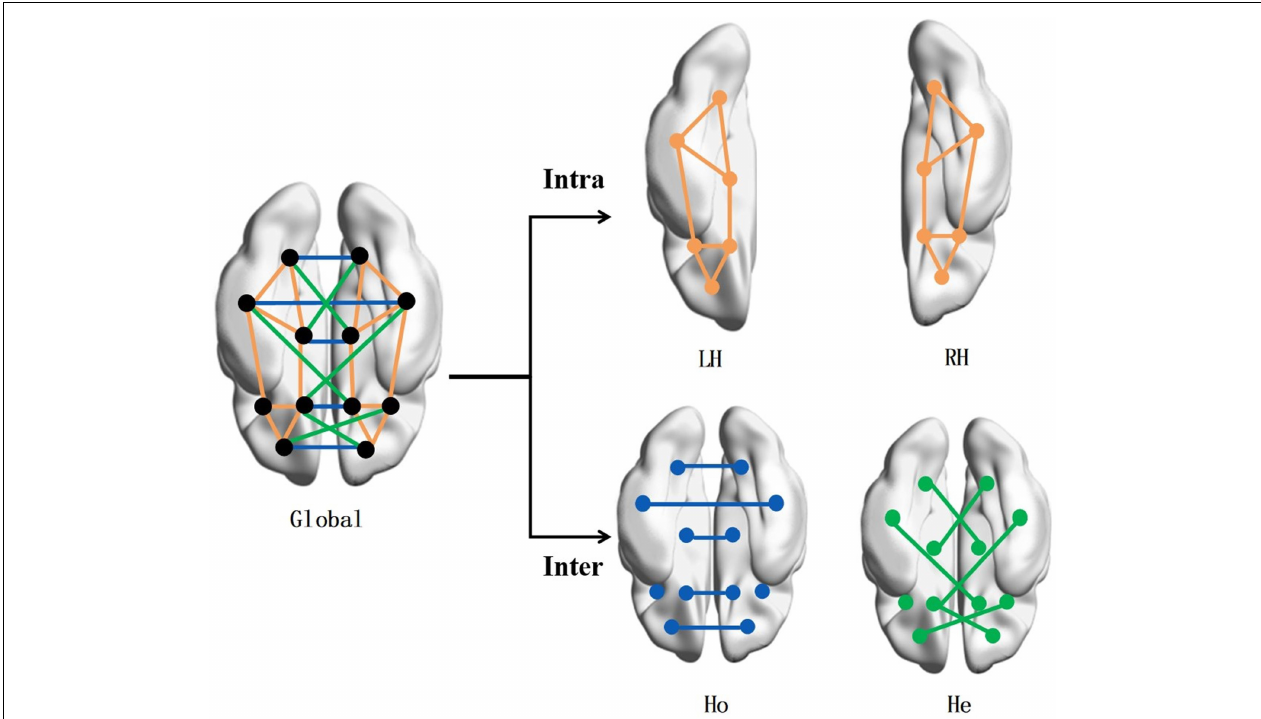
FIGURE 1 | Brain network construction. To study the correlation of brain symmetry on the off-rate of DBS, the brain network is built by intra- and inter-hemispheric connectivity. The connection types include intra-left-hemispheric (LH), intra-right-hemispheric (RH), inter-hemispheric homotopic (Ho), and inter-hemispheric heterotopic